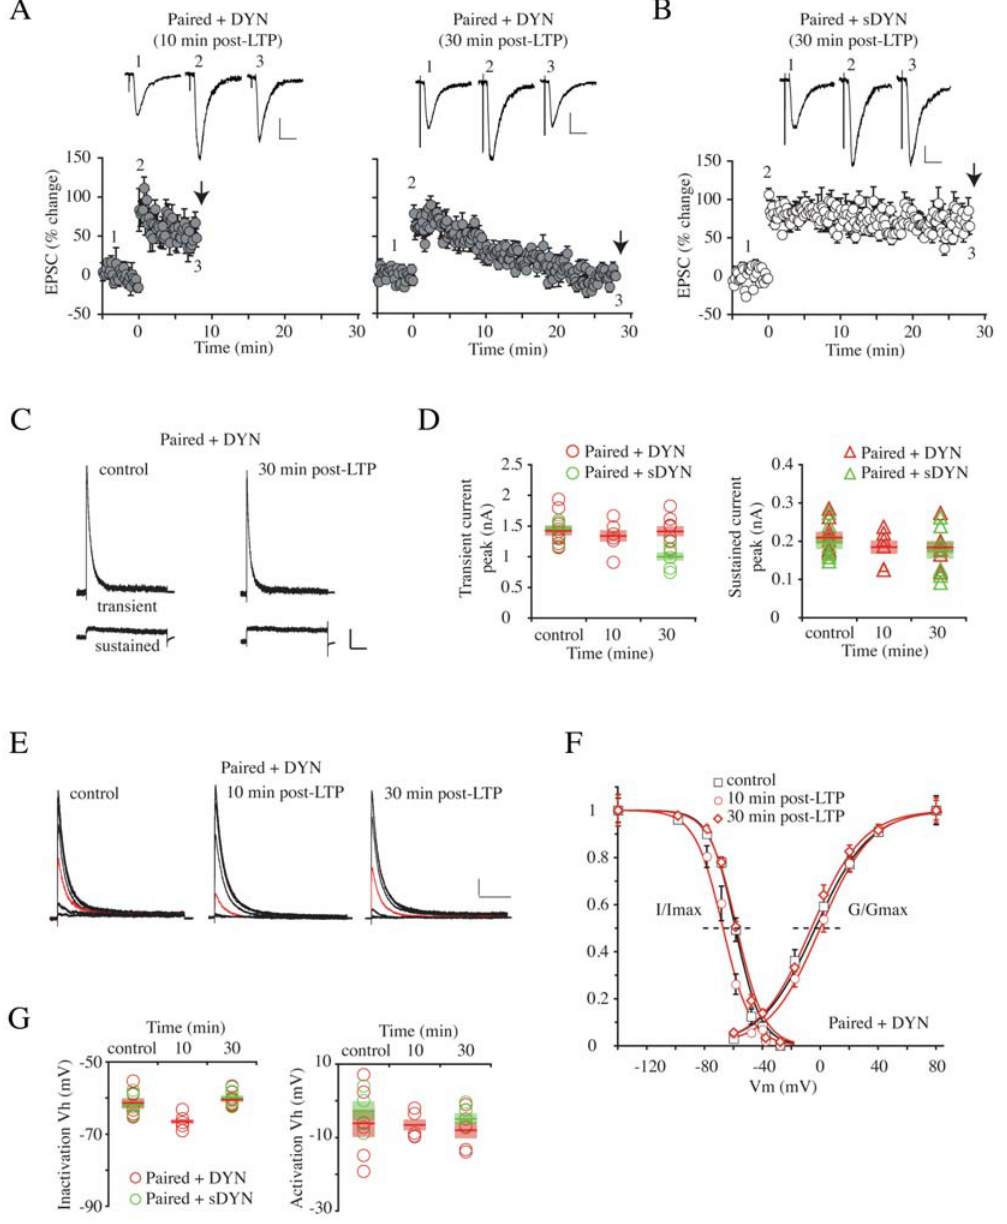
Figure 5. A dynamin-based inhibitory peptide (DYN) blocks LTP and the reduction of A-type K + currents. In these experiments we included DYN in the patch pipette to prevent clathrin mediated endocytosis [12]. Transient and sustained current densities and voltage-dependent properties were observed in nucleated patches pulled either 10 or 30 min after LTP induction and compared with control. A . DYN added to pipette recording solution (100 m g/ml) allows for an initial potentiation 10 min after LTP induction (p , 0.003 compared with control). However, potentiation of synaptic transmission was completely lost 20 min after paired stimulation in the presence of DYN. Inset traces are EPSCs recorded at the indicated time. Scale bars: 50 pA, 20 ms. Error bars represent SEM. B . Scrambled DYN (sDYN, 100 m g/ml) did not affect LTP. The arrows in A and B indicate the time when nucleated patches were formed from whole-cells. Inset traces are EPSCs recorded at the indicated time. Scale bars: 50 pA, 20 ms. Error bars represent SEM. C . Example traces of peak K + currents recorded in the ‘‘Paired + DYN’’ group. In the presence of DYN, peak amplitude of I A was not reduced after paired stimulation. Recording protocols is as in Figure 4A. Scale bars: 200 pA, 100 ms. D . Averaged peak amplitudes of transient and sustained currents after conditioning stimulations in the presence of DYN and sDYN. DYN completely blocked the decrease of I A peak after paired stimulation while a significant reduction of I A was still observed 30 min post-LTP in the ‘‘Paired + sDYN’’ group. Sustained currents did not show any changes in either group. Bars indicate the mean value and semitransparent boxes represent SEM. E . Example traces used to construct steady-state inactivation curves before and after paired stimulation in the presence of DYN. Red traces indicate I A recorded at a + 60 mV from a 2 60 mV membrane potential. Recording protocols is as in Figure 3A. Scale bars: 200 pA, 100 ms. F . Averaged inactivation and activation properties of I A before and after paired stimulation in the presence of DYN. The left-shifted inactivation curve of I A was still observed 10 min after LTP induction. For comparison, the results of sDYN are shown in Figure S2. Error bars represent SEM. G . Averaged changes of V h (dotted lines in F ) in the presence of DYN (red symbols) or sDYN (green symbols). V h of steady-state inactivation showed a significant change only10 min after LTP induction, consistent with results of experiments performed without DYN. Bars indicate the mean value and semitransparent boxes represent SEM.